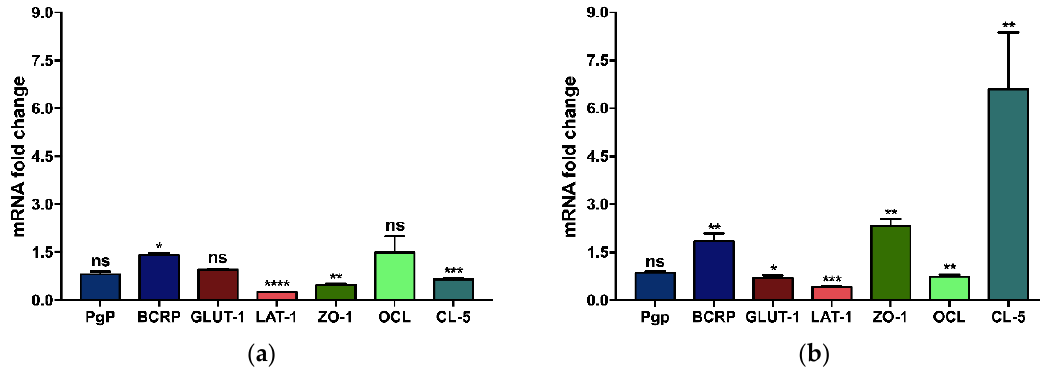
Figure 4. Differences in the fold-change of gene expression between ( a ) BMEC and ( b ) bEnd.3 cells grown on a polyester membrane insert filter compared to cells grown on plastic cell culture flask. Relative gene expression was calculated using the 2 −ΔΔCt method, with HPRT as the housekeeping gene and cells grown on the plastic cell culture flask as the calibrator. Data were analyzed using an unpaired t test with Welch ’ s correction (ns: p ≥ 0.0332, * p < 0.0332, ** p < 0.0021, *** p < 0.0002, **** p < 0.0001). The bars indicate the average mRNA fold change ± SD ( n = 3).